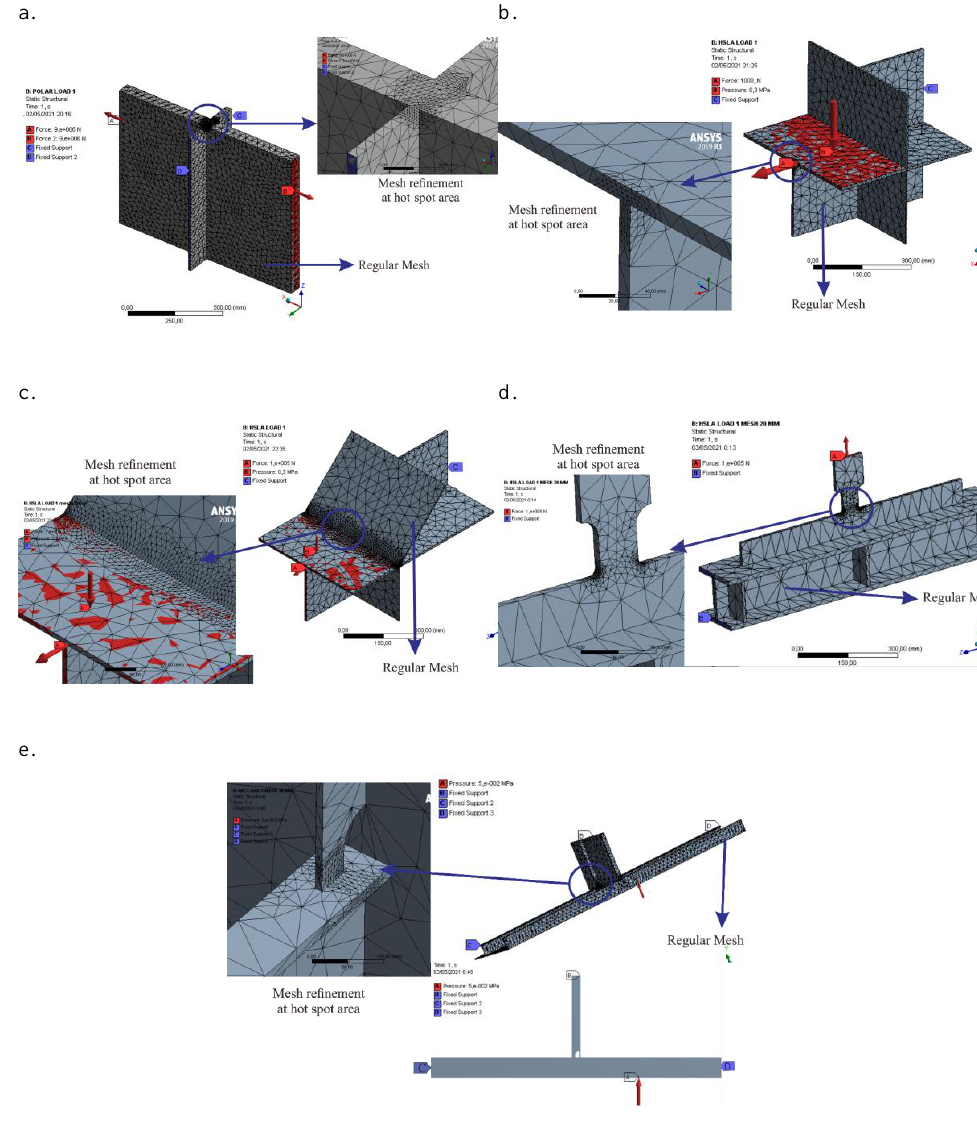
Figure 6. Meshing and Boundary Conditions: a. Geometry 1: Hatch Coaming Model [16]; b. Geometry 2: Figure 6: Meshing and boundary conditions: a. Geometry 1: Hatch coaming model [16]; b. Geometry 2: Perpendicular joint [12]; c. Geometry Perpendicular Joint [12]; c. Geometry 3: Stool Joint [12]; d. Geometry 4: Bottom-Stiffened Panel [27]; e. Geometry 3: Stool joint [12]; d. Geometry 4: Bottom-stiffened panel [28]; e. Geometry 5: Side-stiffened panel 5: Side-Stiffened Panel [28]